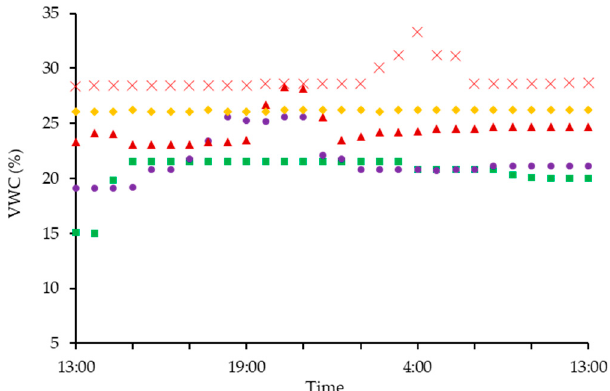
Figure 7. VWC at the slope gradient of 8° and the water application rate of 4.0 mm·h − 1 , with soil depths of 10 cm ( ■ ), 20 cm ( ● ) 30 cm ( ▲ ), 40 cm (×), and 50 cm ( ◆ ).